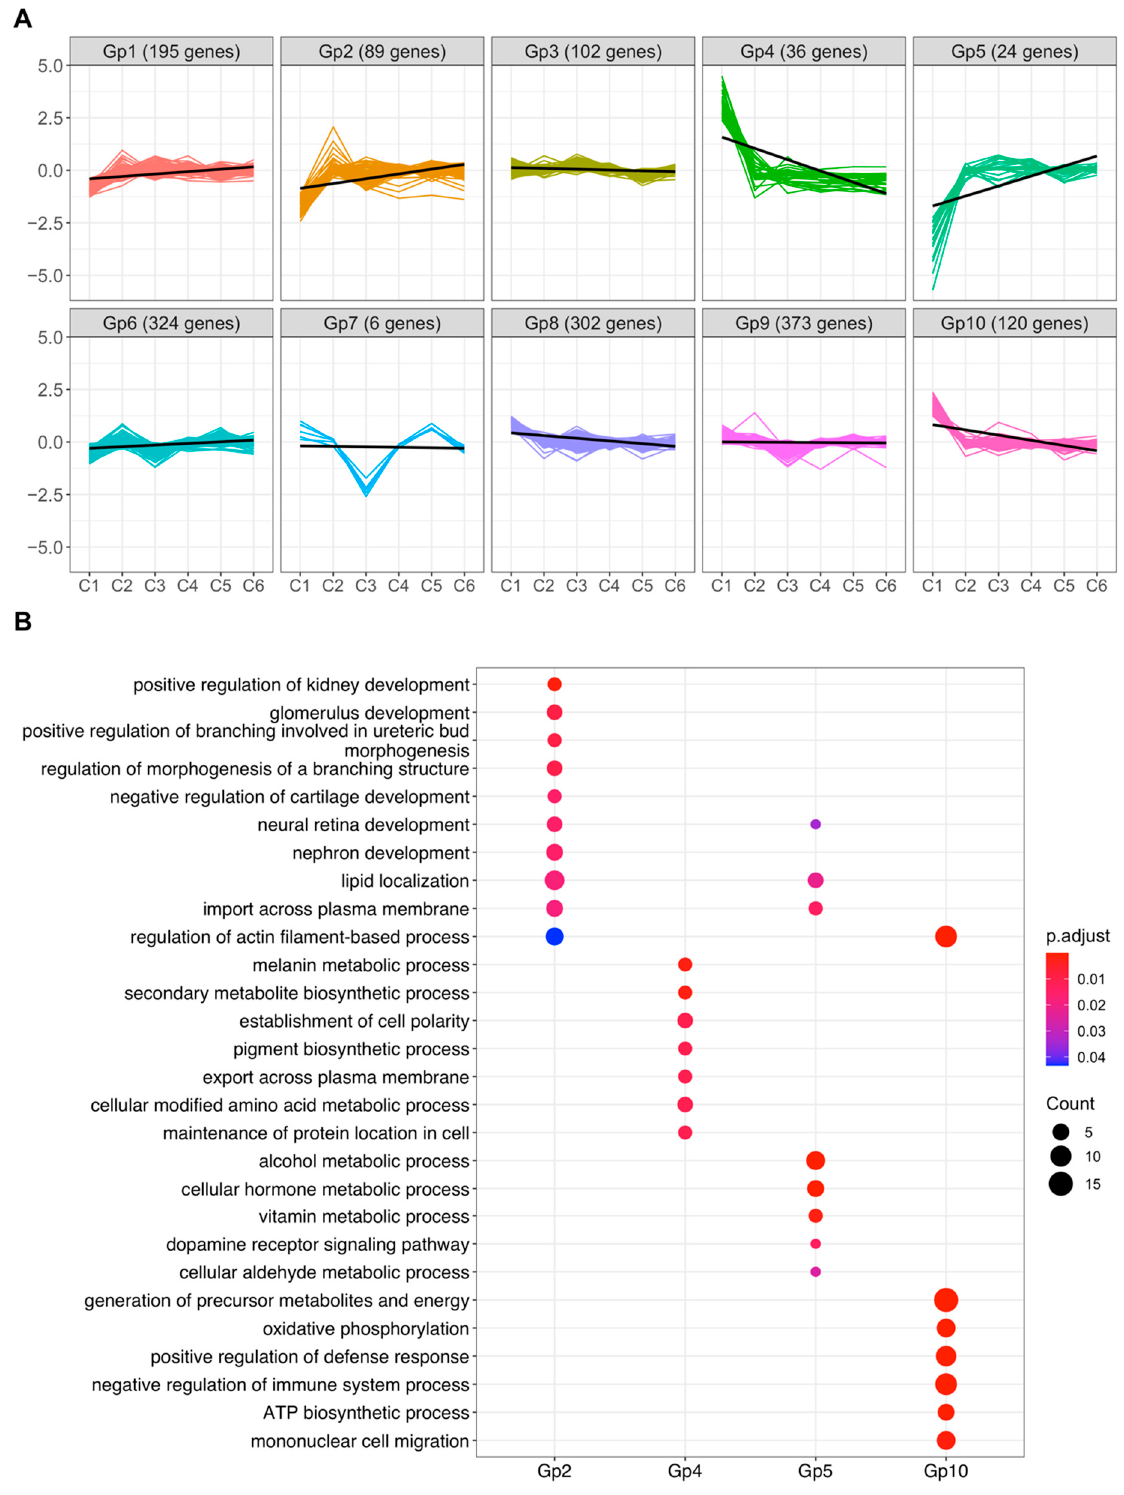
Figure 5. Characterization of RPE subpopulations from R1. ( A ) k-means clustering of differentially expressed genes in RPE cell populations from R1. Clustering analysis identified 10 groups of genes with distinct expression profiles across possible maturation timeline, each plotted in a different color. Number of genes in each group are shown in parentheses ( B ) Enrichment of biological processes in selected groups using clusterprofiler. The significance threshold for all enrichment analyses was set to 0.05 using Benjamini–Hochberg corrected p -values.